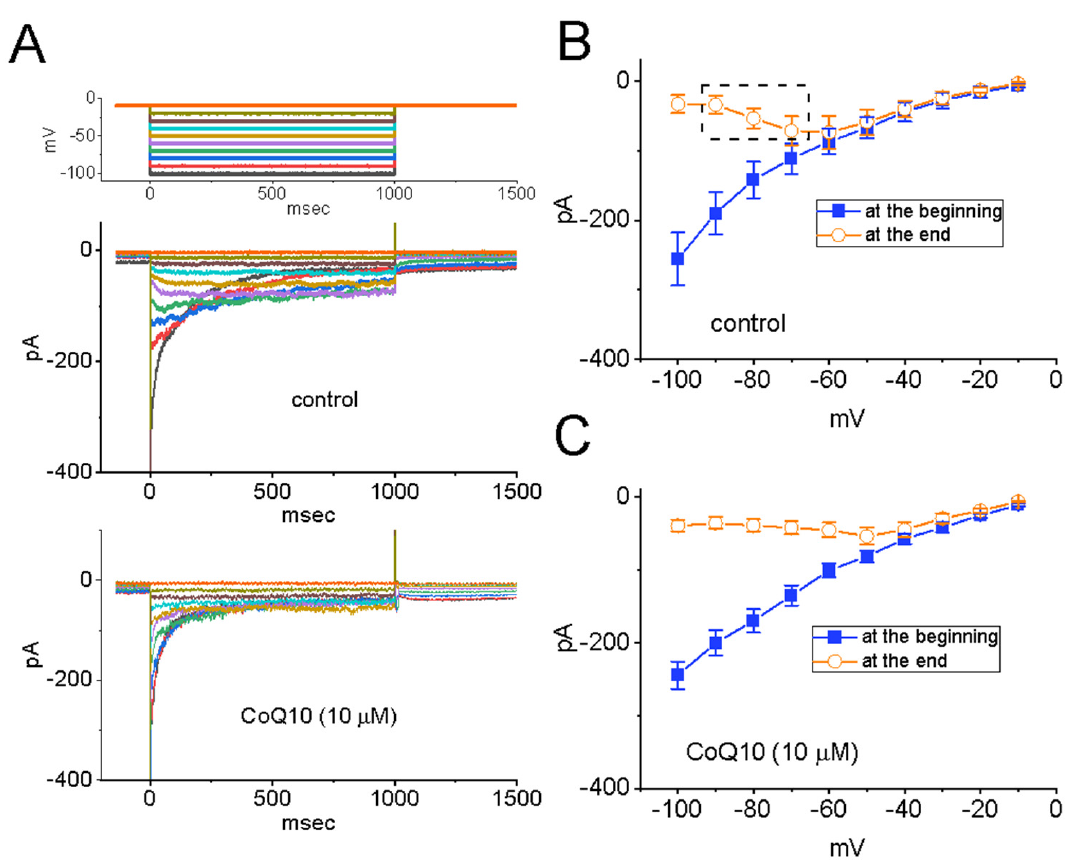
Figure 4. Mild inhibitory effect of ubiquinone (CoQ10) on the erg -mediated K + current ( I K(erg) ) in GH 3 cells. In these experiments, the cells were immersed in a high-K + (around 140 mM of K + ), Ca 2+ -free solution, and the recording pipette was filled with a K + -containing internal solution. ( A ) Representative current traces obtained with (their lower part) and without (their upper part) the addition of 10 µ M of CoQ10. The uppermost part denotes the voltage-clamp protocol applied to the examined cells. Of note, the potential traces shown in different colors correspond to the current traces activated in response to each hyperpolarizing voltage. ( B , C ) show the I–V relationships of the peak of CoQ10, respectively. The current amplitude was recorded at the beginning ( (cid:4) ) and the end ( of each 1 s-long hyperpolarizing voltage pulse from a holding potential of − 10 mV. Each point is the mean ± SEM (n = 8, for each point). The dashed box in ( B ) indicates the voltage-dependent inactivation of the I K(erg) present in these cells, according to the steady-state I–V relationship of sustained I K(erg)